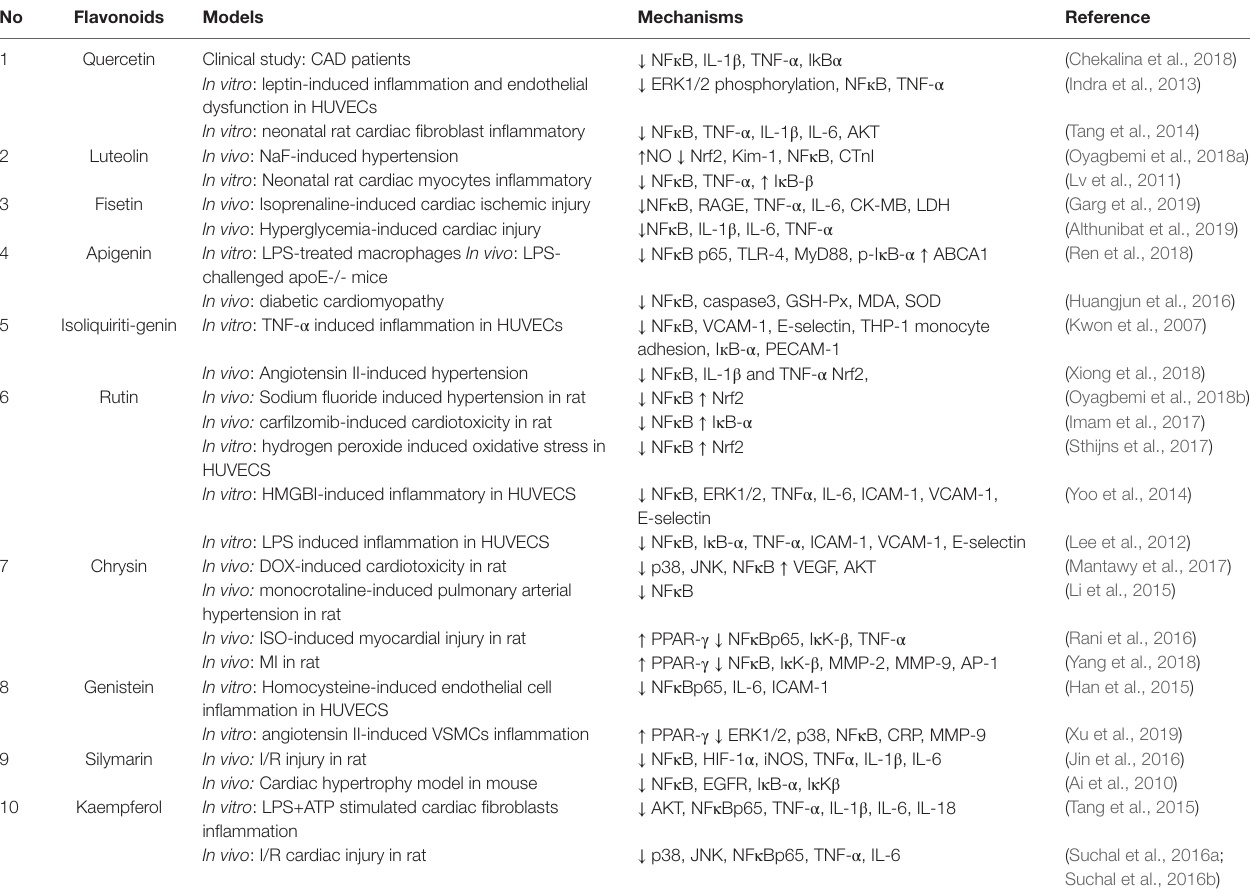
TABLe 1 | Effect of flavonoids in